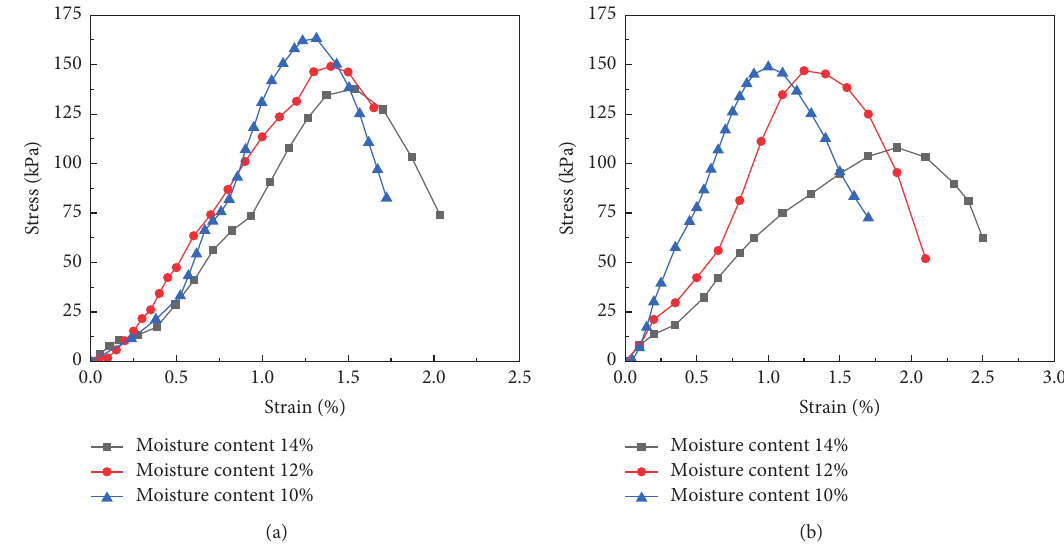
Figure 2: Stress-strain results of site soil samples: (a) sample made with pure water and (b) samples prepared with pit water from the